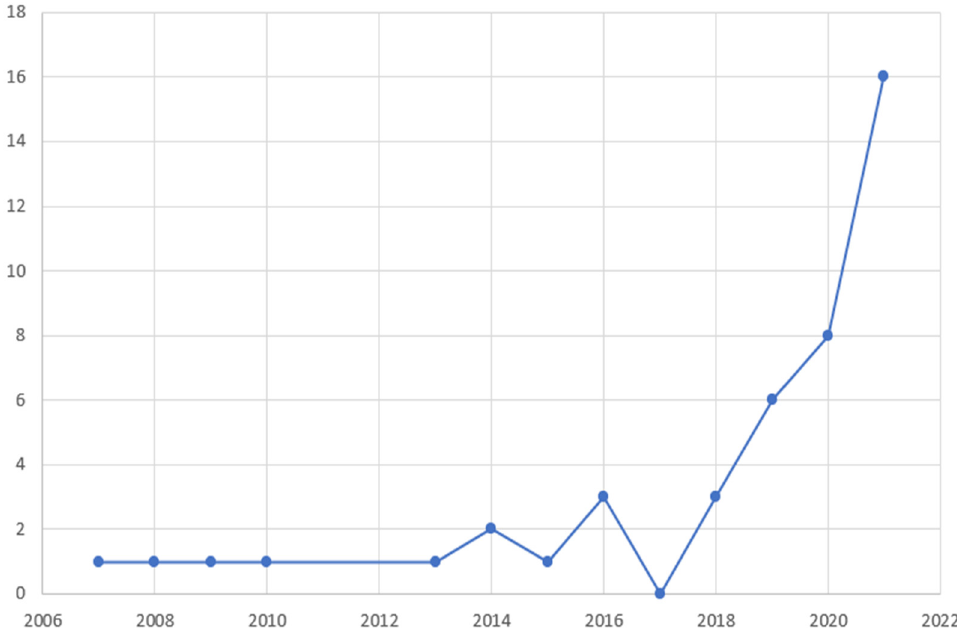
Figure 3. Temporal distribution of the studies included in the review according to year of publica- tion.